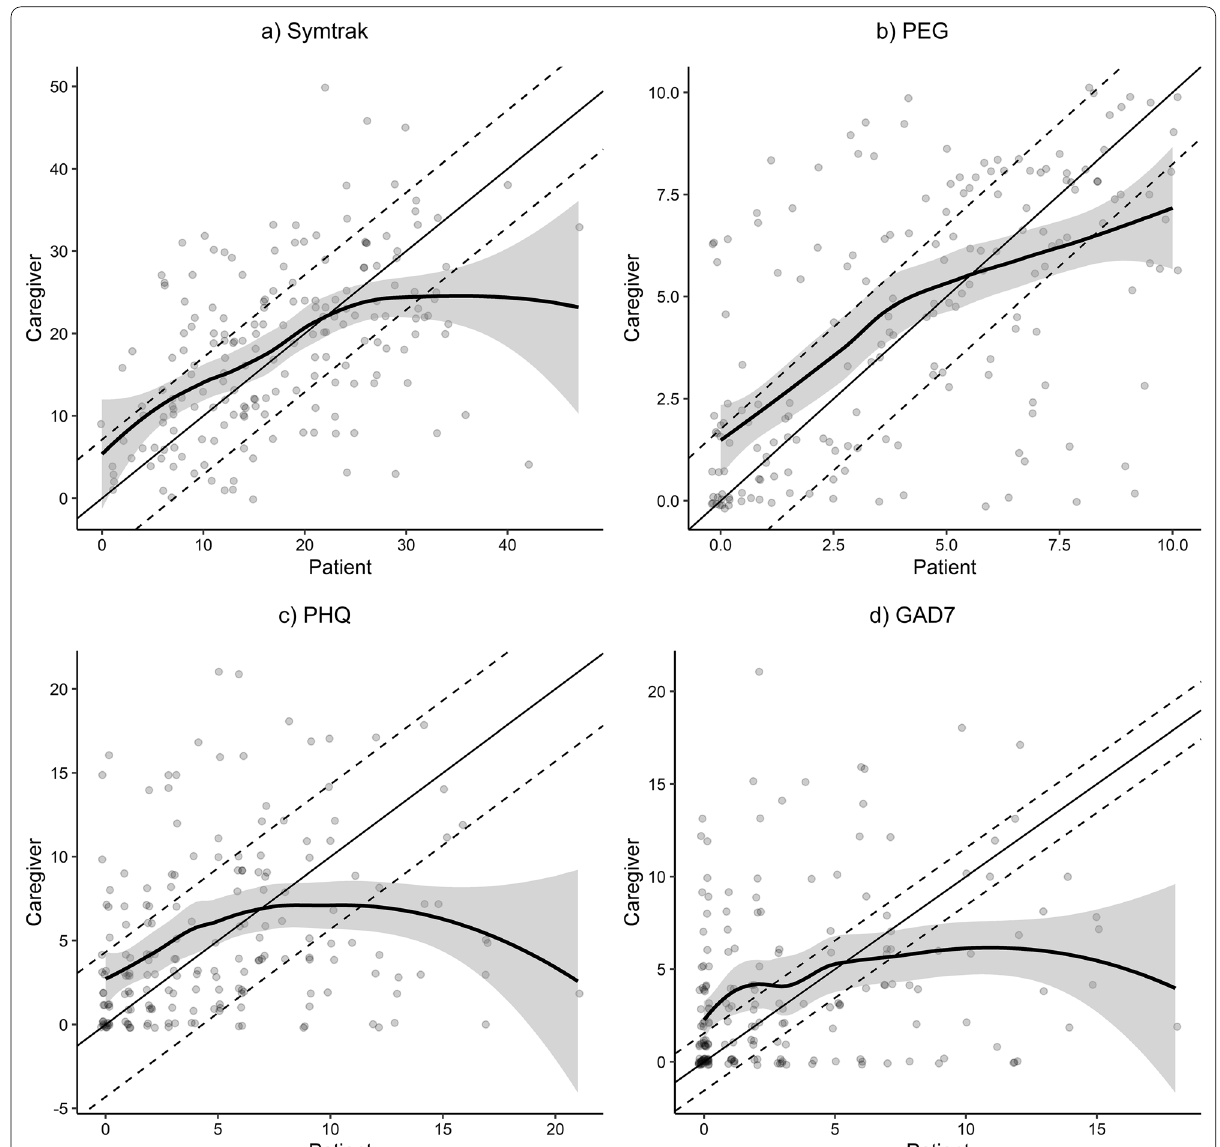
Fig. 1 Scatter plot of Caregiver (Proxy) Report versus Patient Self-Report for Patient Symptoms on 4 Scales: a SymTrak multimorbidity scale; b PEG pain scale; c PHQ-8 depression scale; d GAD-7 anxiety scale. Higher scores on all 4 scales indicates greater (worse) symptom severity. The solid straight line represents theoretical perfect agreement and the dotted lines are the measurement error bars representing measurement). The solid curvilinear line represents the fitted actual agreement derived from linear regression and the shaded area represents the confidence limits around the actual